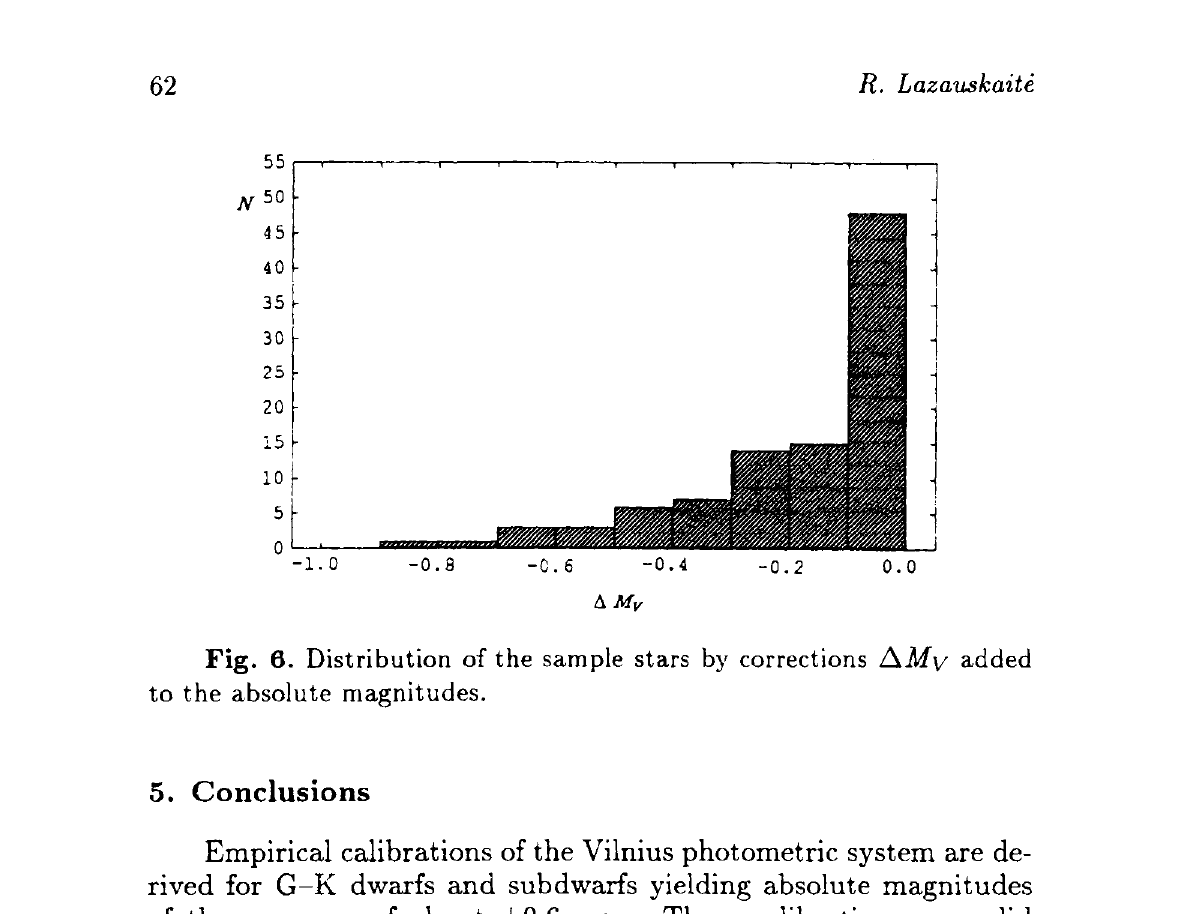
Fig. 6. Distribution of the sample stars by corrections A My added to the absolute